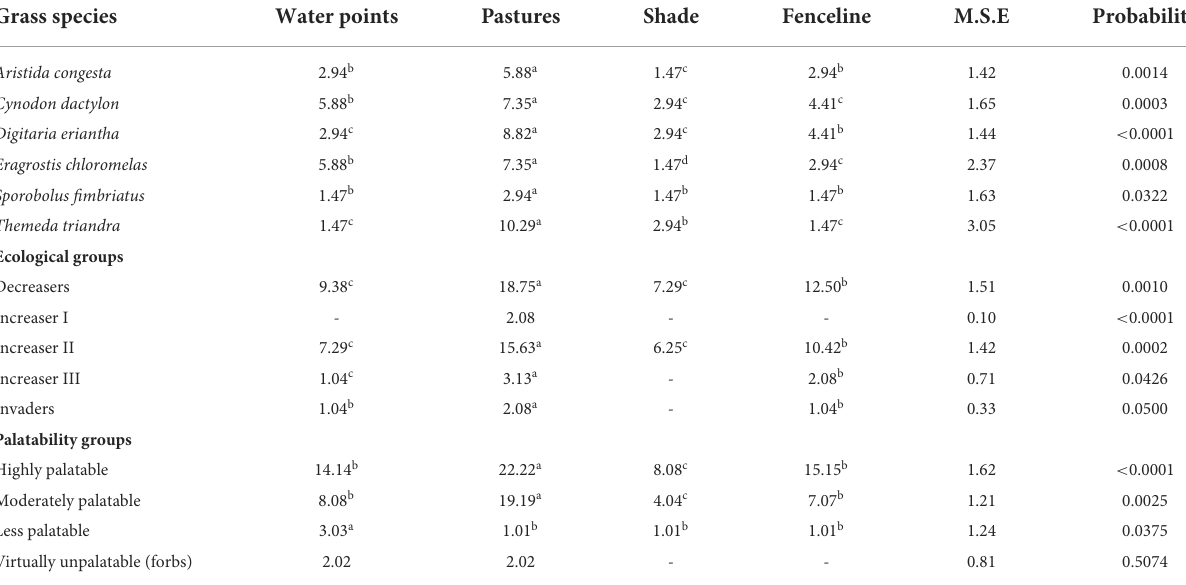
TABLE 1 Relative abundance (%) of common grass species, ecological, and desirability groups at different locations within a paddock. Grass species Water points Pastures Shade Fenceline M.S.E Probability